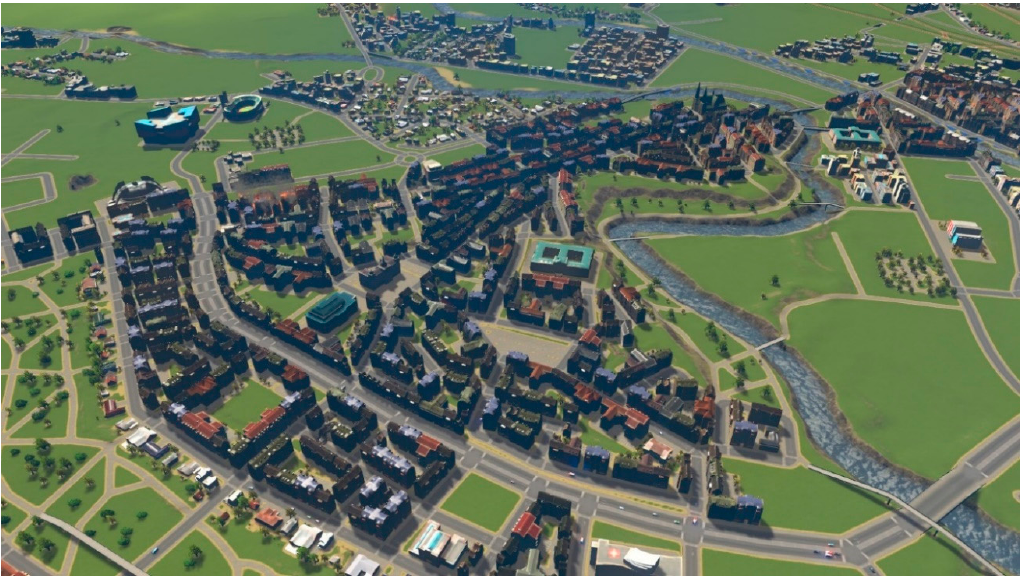
Figure 8. A playable model of Olomouc in Cities: Skylines (historic center).